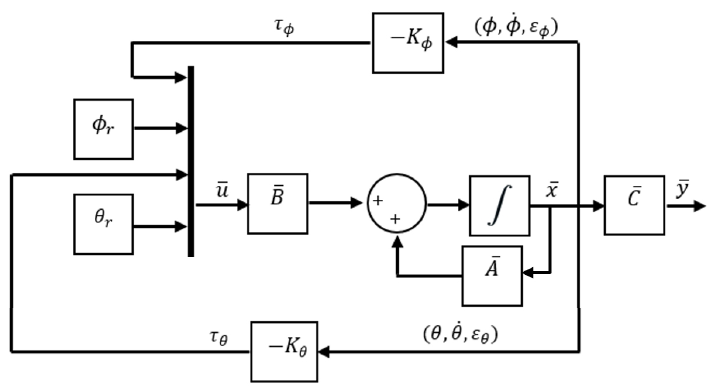
Figure 14. State feedback control